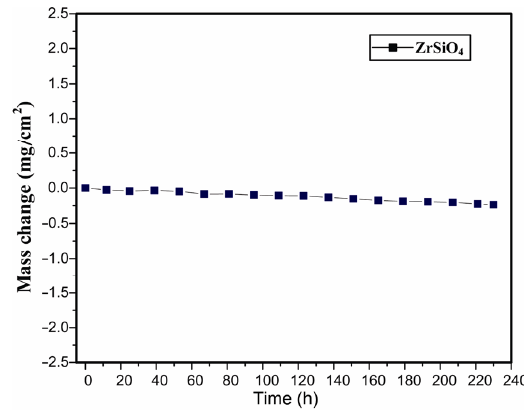
Fig. 4 Weight loss of ZrSiO 4 bulk in 90%H 2 O/10%O 2 at 1300 ℃ .